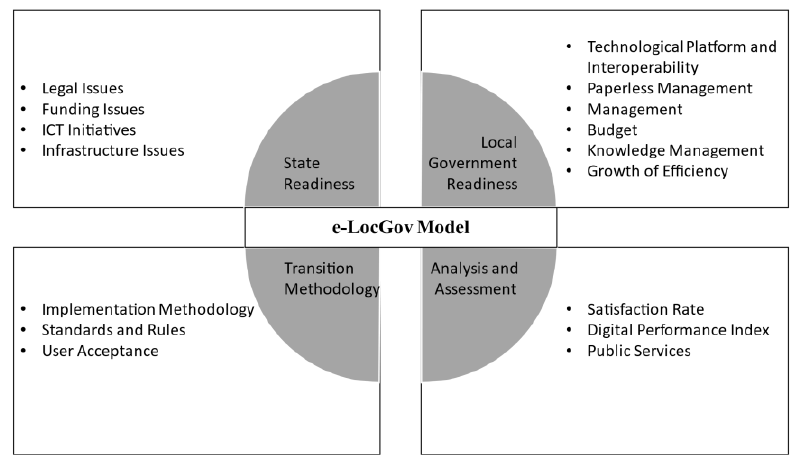
Figure 1: The Four Areas in e-LocGov model by Pappel et al. (2021)